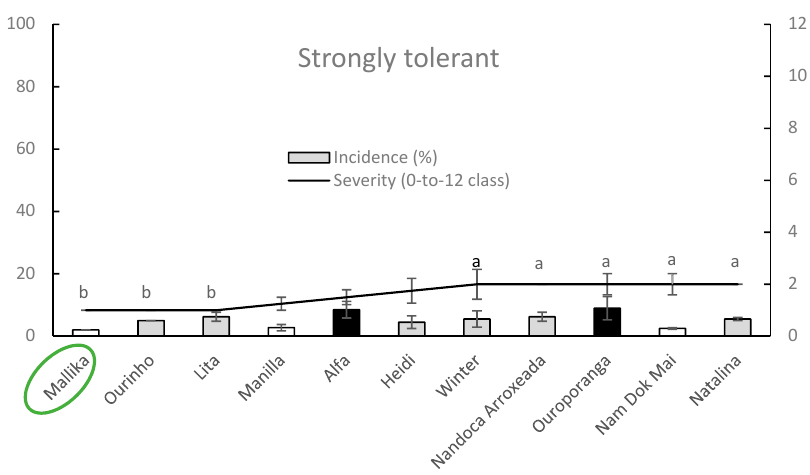
Figure 5. Column-line graphs on two axes comparing anthracnose DI and SS caused by C. asianum within strongly tolerant mango cultivars. Average DI and SS data from three monitoring times (± SE: standard error) are the means of four replicates (plants) obtained from disease incidence on each canopy and 16 leaves per plant, respectively. Arcsine transformation was used on percentage data prior to analysis, whereas untransformed data are presented. Black and white columns are significantly different among them according to Fisher’s least significant difference test at α = 0.05 while grey color denotes intermediate behavior (not significant). Differences among severity data on-line among cultivars (points followed by different letters) were analyzed with Kruskal–Wallis one-way analysis of variance by ranks followed by all pairwise multiple comparisons with Mann–Whitney test. The missing letters denote non-significant differences from all remaining severity values.